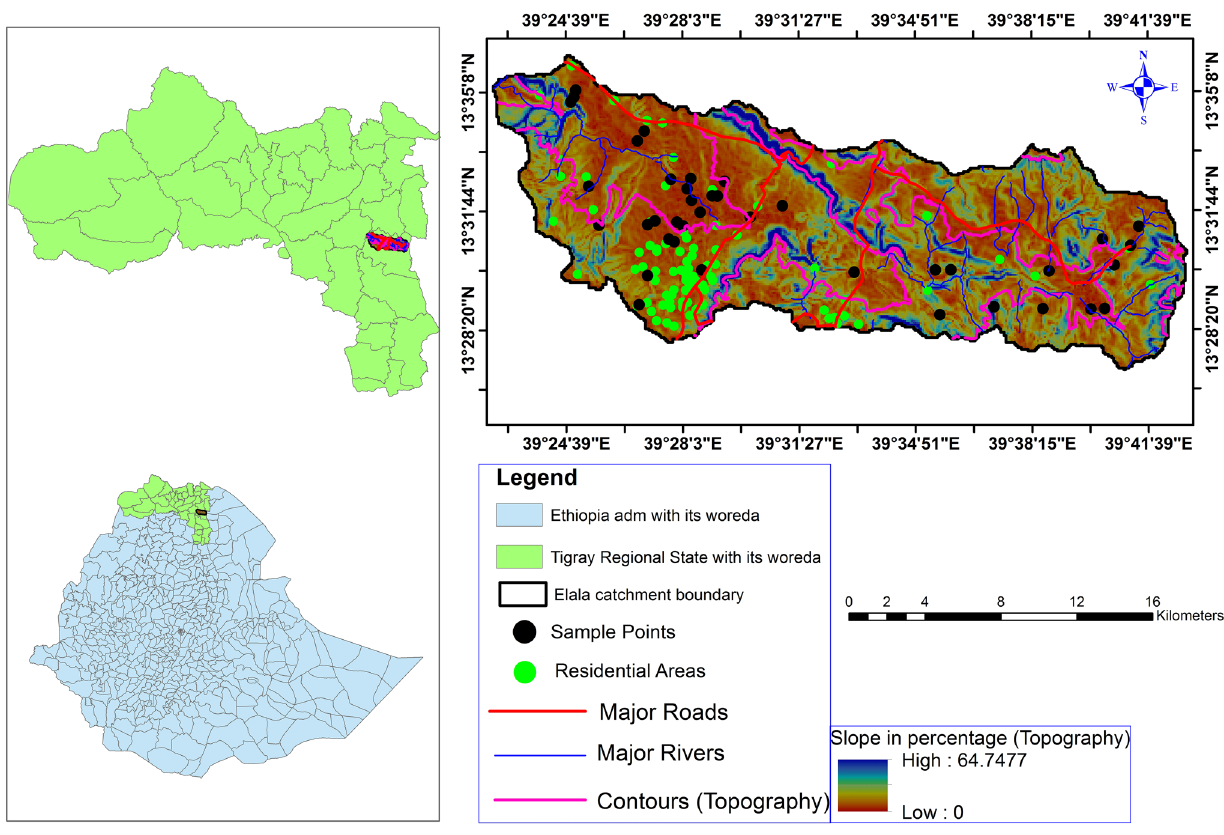
Fig. 1 Location map of the study area